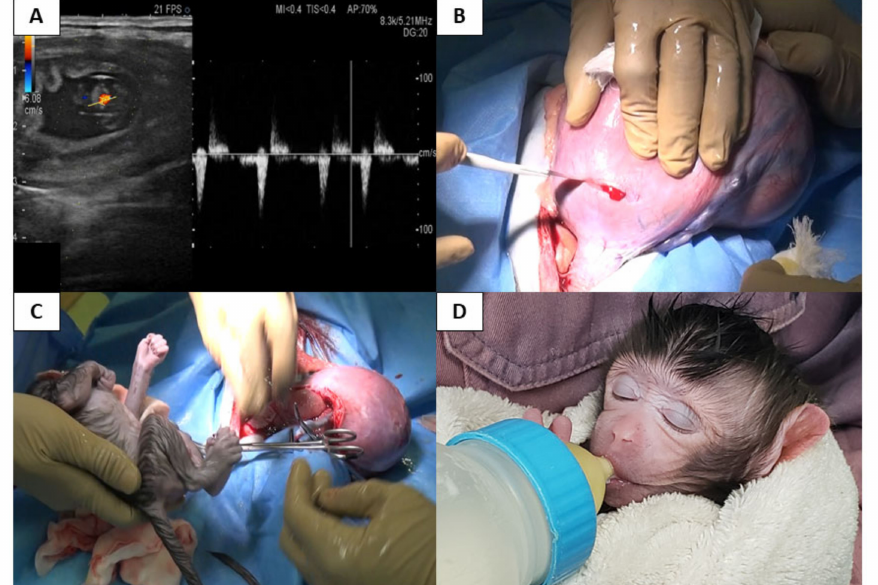
Figure 12. Placenta accreta in transplanted uterus. ( A ) Placenta accreta was observed intraoperatively during cesarean